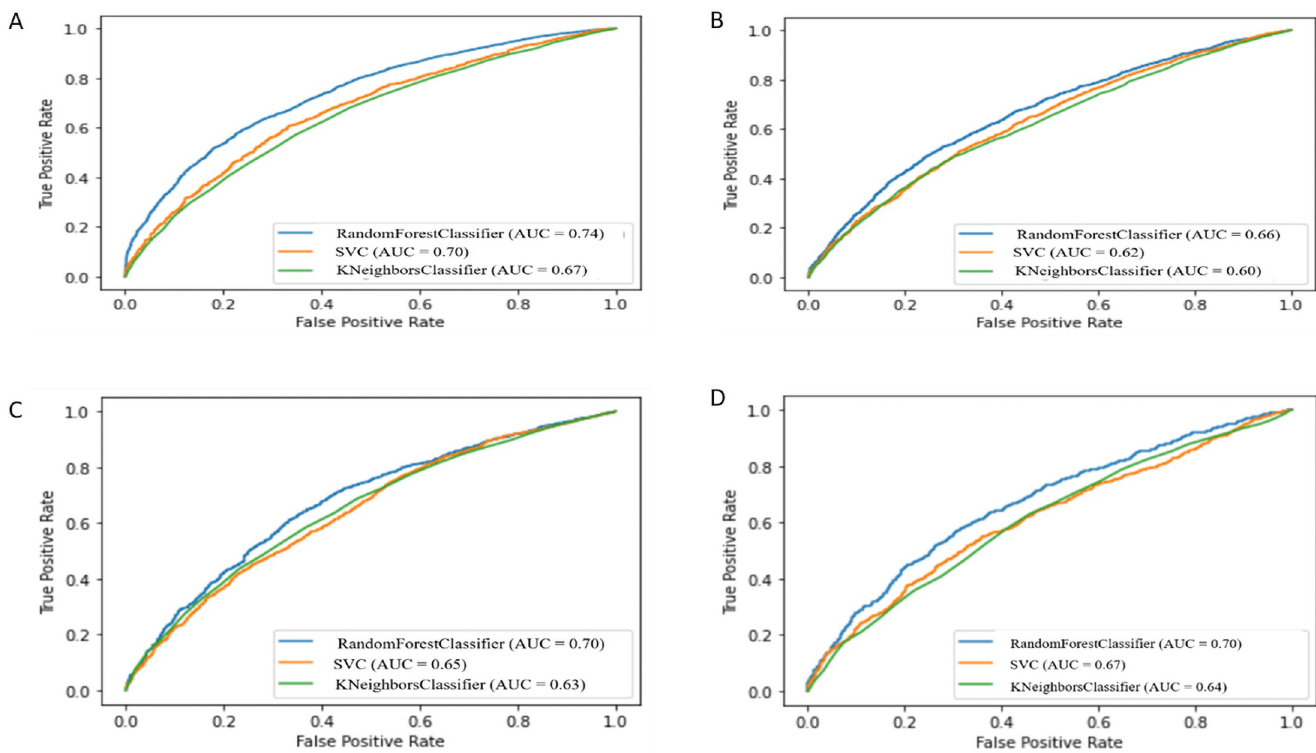
Fig 3. ROC curves of different classifiers. (A) Motorcyclists (B) Bicyclists (C) Pedestrians (D) VRUs. rate and false positive rate for different VRU types by different classifier models are shown in Fig 3.